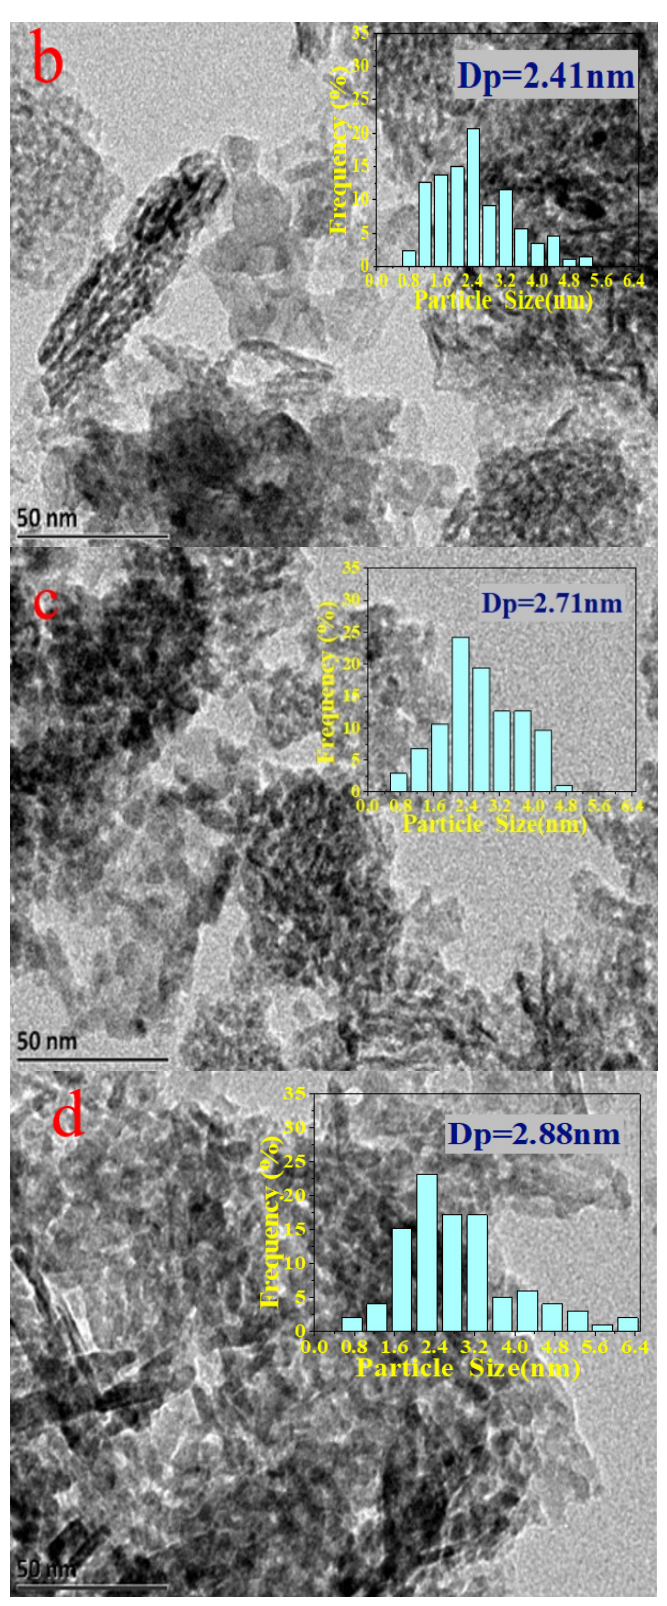
Figure 4. TEM images of Ni 10 Mo 10 Al catalysts calcined at ( a ) 450 °C, ( b ) 550 °C, ( c ) 650 °C and ( d ) Figure 3. TEM images of Ni 10 Mo 10 Al catalysts calcined at ( a ) 450 ◦ C, ( b ) 550 ◦ C, ( c ) 650 ◦ C and 750 °C after reduction at 450 °C. ( d ) 750 ◦ C after reduction at 450 ◦